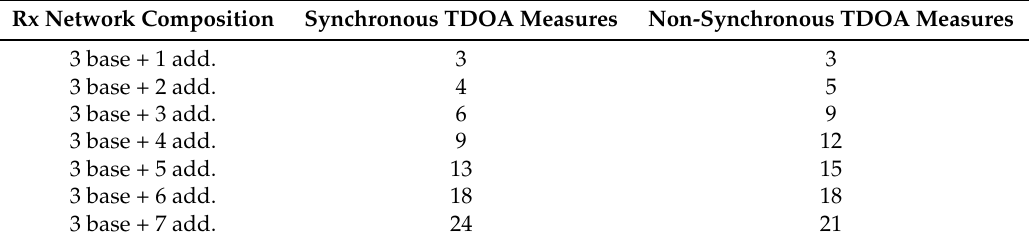
Number of synchronous and non-synchronous Time Difference Of Arrival (TDOA) measurements for the different configurations of the receivers network. Rx Network